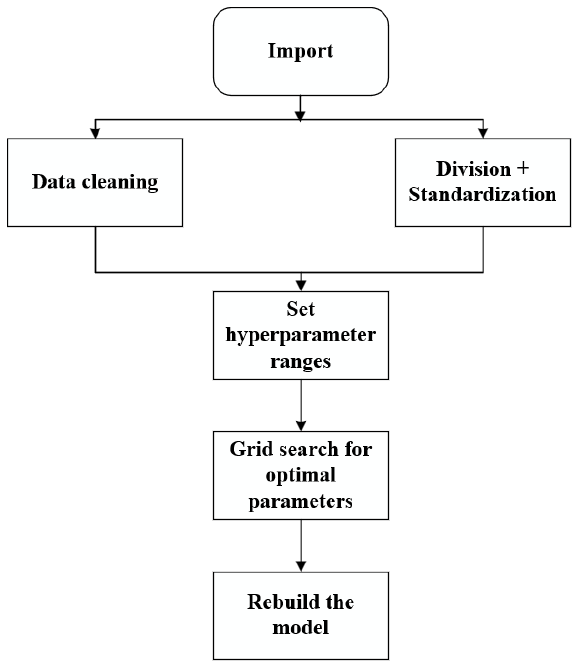
Figure 8. KNN algorithm